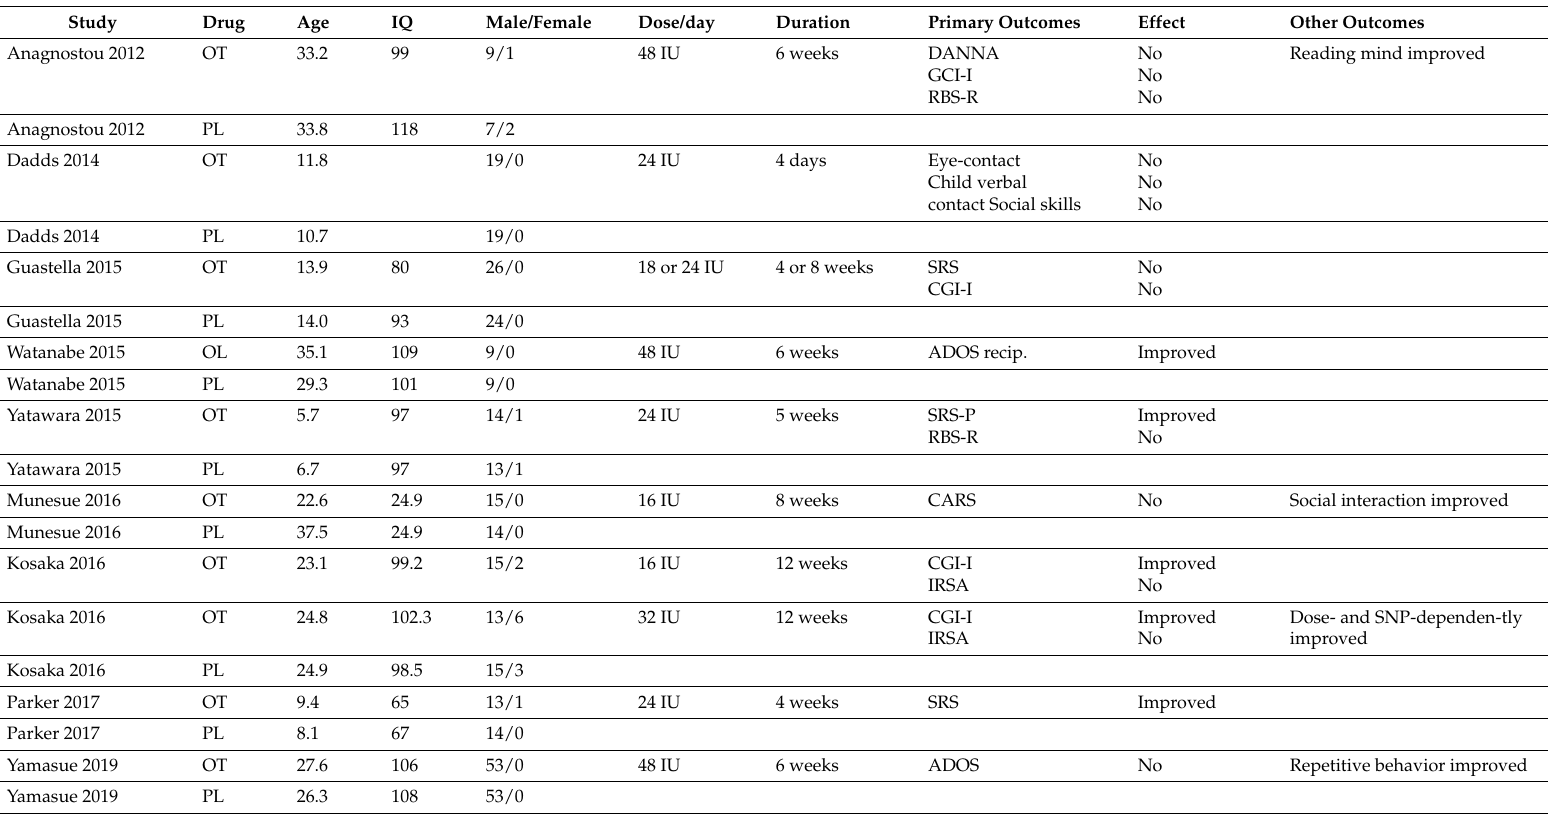
Table 1. Effects of intranasal repetitive application of oxytocin on individuals with autism spectrum disorder (ASD) in randomized controlled trials. Study Primary Outcomes Effect